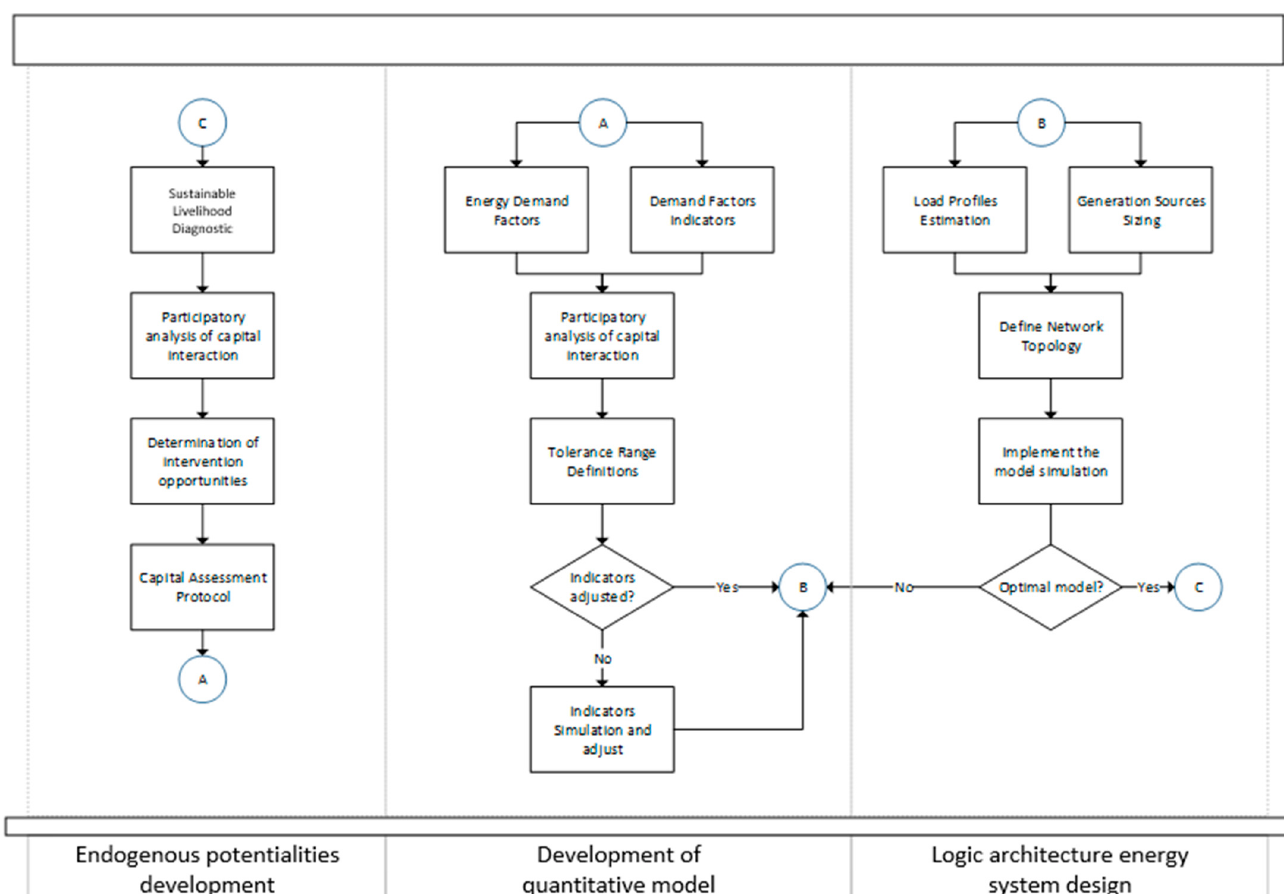
Figure 2. Proposed elements for planning energy supply systems in remote communities on the basis of endogenous factors.